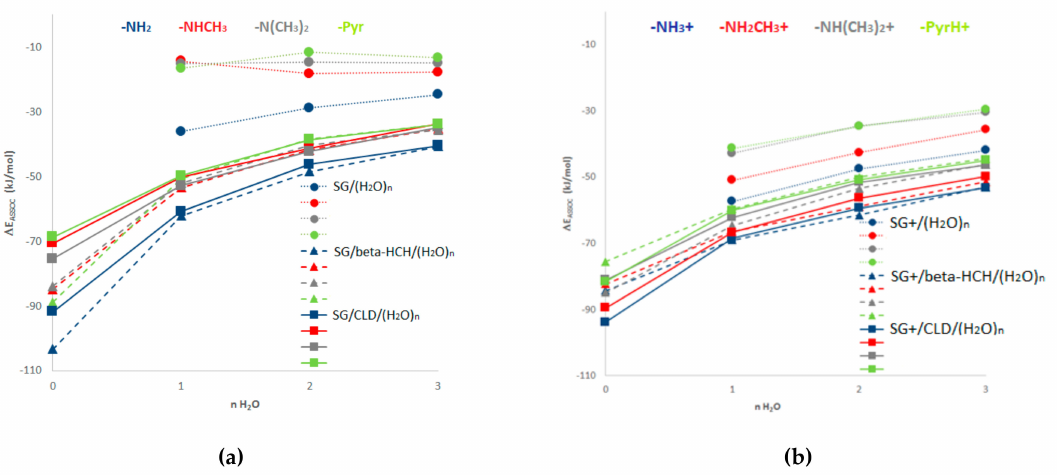
Figure 3. Thermodynamic association energy ( ∆ E ASSOC ) for the systems SG/(H 2 O) n=1–3 , SG/ β -HCH/(H 2 O) n=0–3 and SG/CLD/(H 2 O)n =0–3 including the charged forms of SG. ( a ) Neutral and basic pH condition ( β -HCH and CLD molecule and neutral SG); ( b ) acidic pH condition ( β -HCH and CLD molecule and protonated